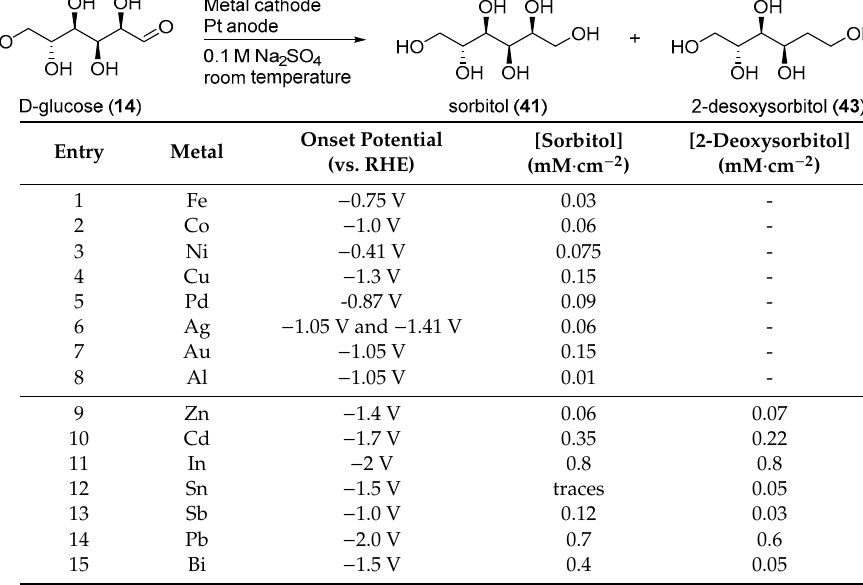
Table 9. Screening of pure metal electrodes for the electro-reduction of glucose to sorbitol.